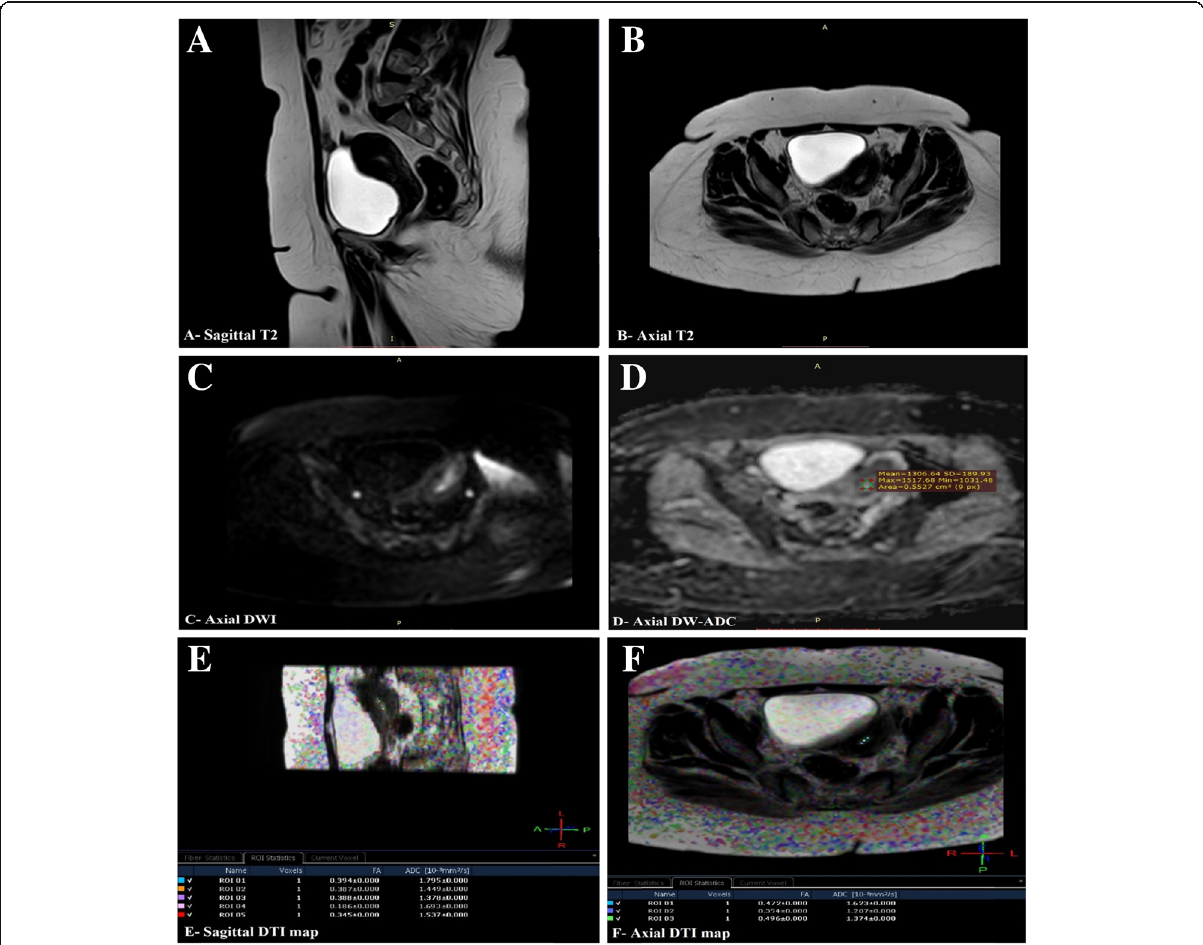
Fig. 2 A 55-year-old postmenopausal female with endometrial thickness 5mm by TVS. a , b Sagittal and axial T2 WIs show normal zonal anatomy of the uterus. The central high signal stripe represents the endometrium (red arrows); the adjacent band of low signal intensity represents the junctional zone (yellow arrows). The outer myometrium is of intermediate SI (white arrows). c Axial DWI with b value of 1000s/mm 2 shows normal appearance of the endometrium with high signal intensity (arrow). d Axial DW-ADC map image shows normal appearance of the endometrium with intermediate signal intensity. Mean DW-ADC value = 1.306 × 10 − 3 mm 2 /s. e, f Sagittal and axial DTI map images demonstrate values of DT-FA, and DT-ADC (MD) in multiple ROI along the endometrial stripe. Mean DT-FA value = 0.378, and mean DT-ADC (MD) value = 1.51 × 10 − 3 mm 2 /s. Diagnosis: normal